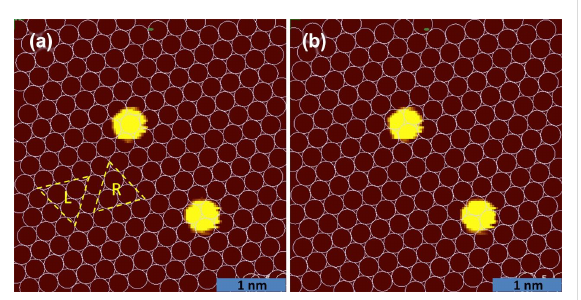
Figure 4: Determination of surface atom positions via geometric argu- mentation: The two panels show STM images with the topography colour scale tuned to reduce the apparent size of the two adatoms to match the superimposed surface lattice pattern. The full apparent size of Au adatoms on Au(111) is around 1 nm as shown in Figure 2b. (a) shows the two possible triangular hollow adsorption sites that we call ‘L’ and ‘R’ sites, depending on their orientations. It also shows that in this setting of the surface atoms one of the two adatoms sits on top of a surface, which is energetically not favourable. (b) The right image with one atom on ‘L’ and the other on ‘R’ is showing the correct posi- tioning (energetically favourable) of the adatoms with reference to the surface